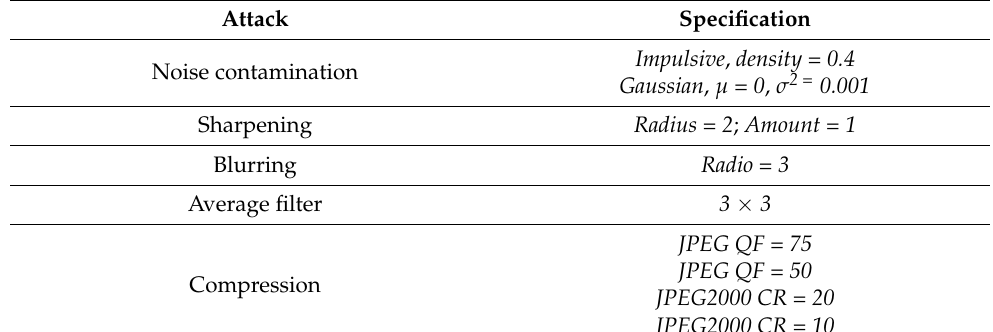
Table 2. Image processing